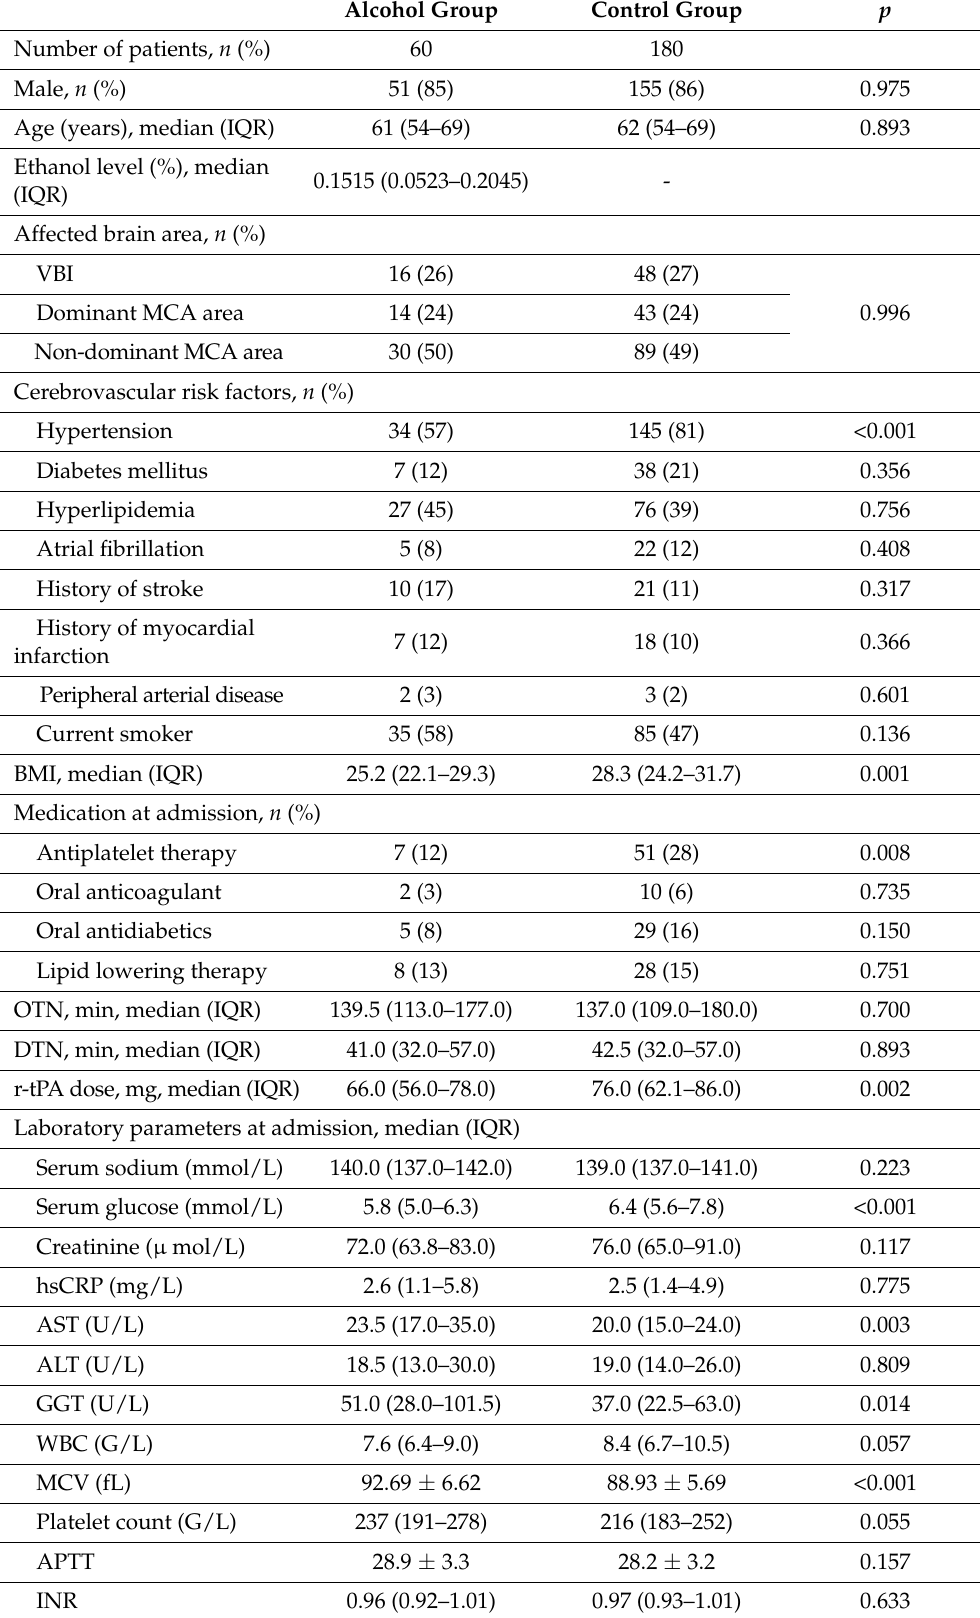
Table 1. Baseline characteristics and outcome of cases (alcohol group) and